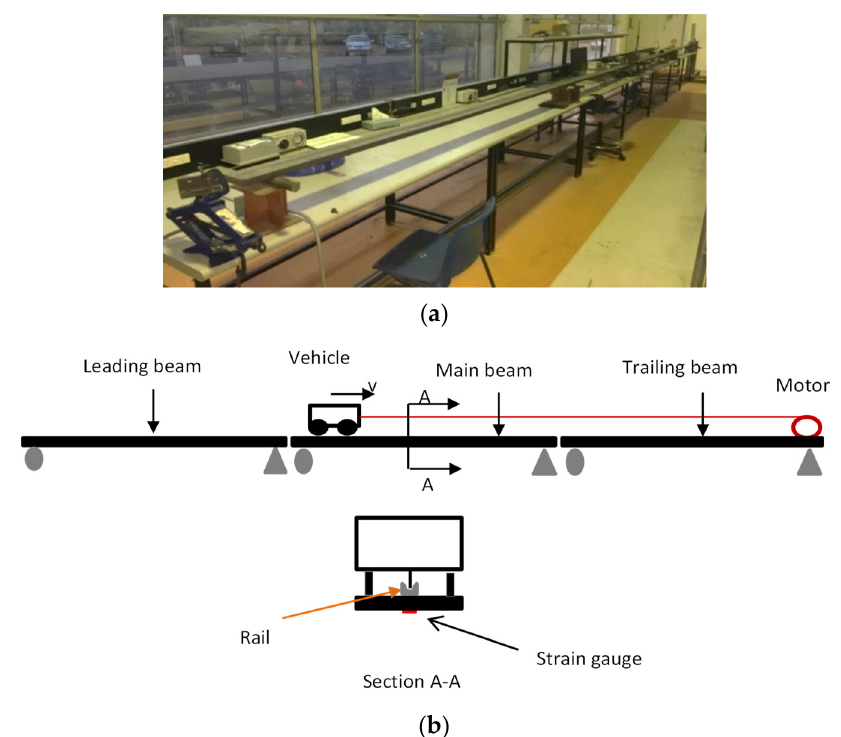
Figure 13. Experimental set-up of the vehicle-bridge system. ( a ) Laboratory model; ( b ) Symbolic